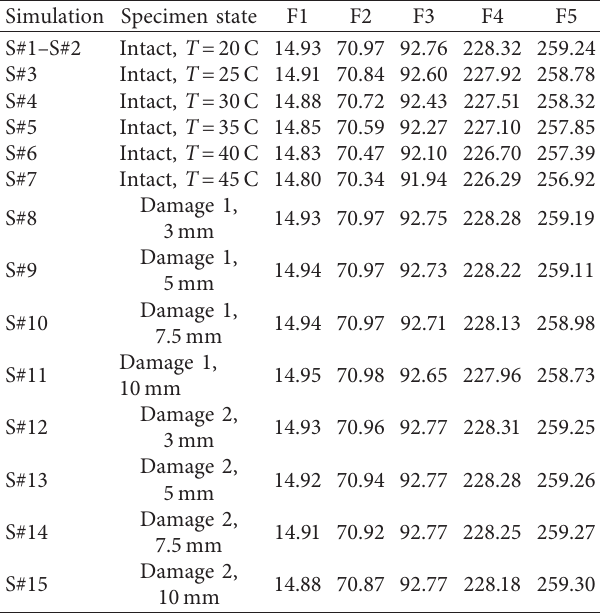
Table 1: List of numerical simulations along with the first five natural frequencies of the